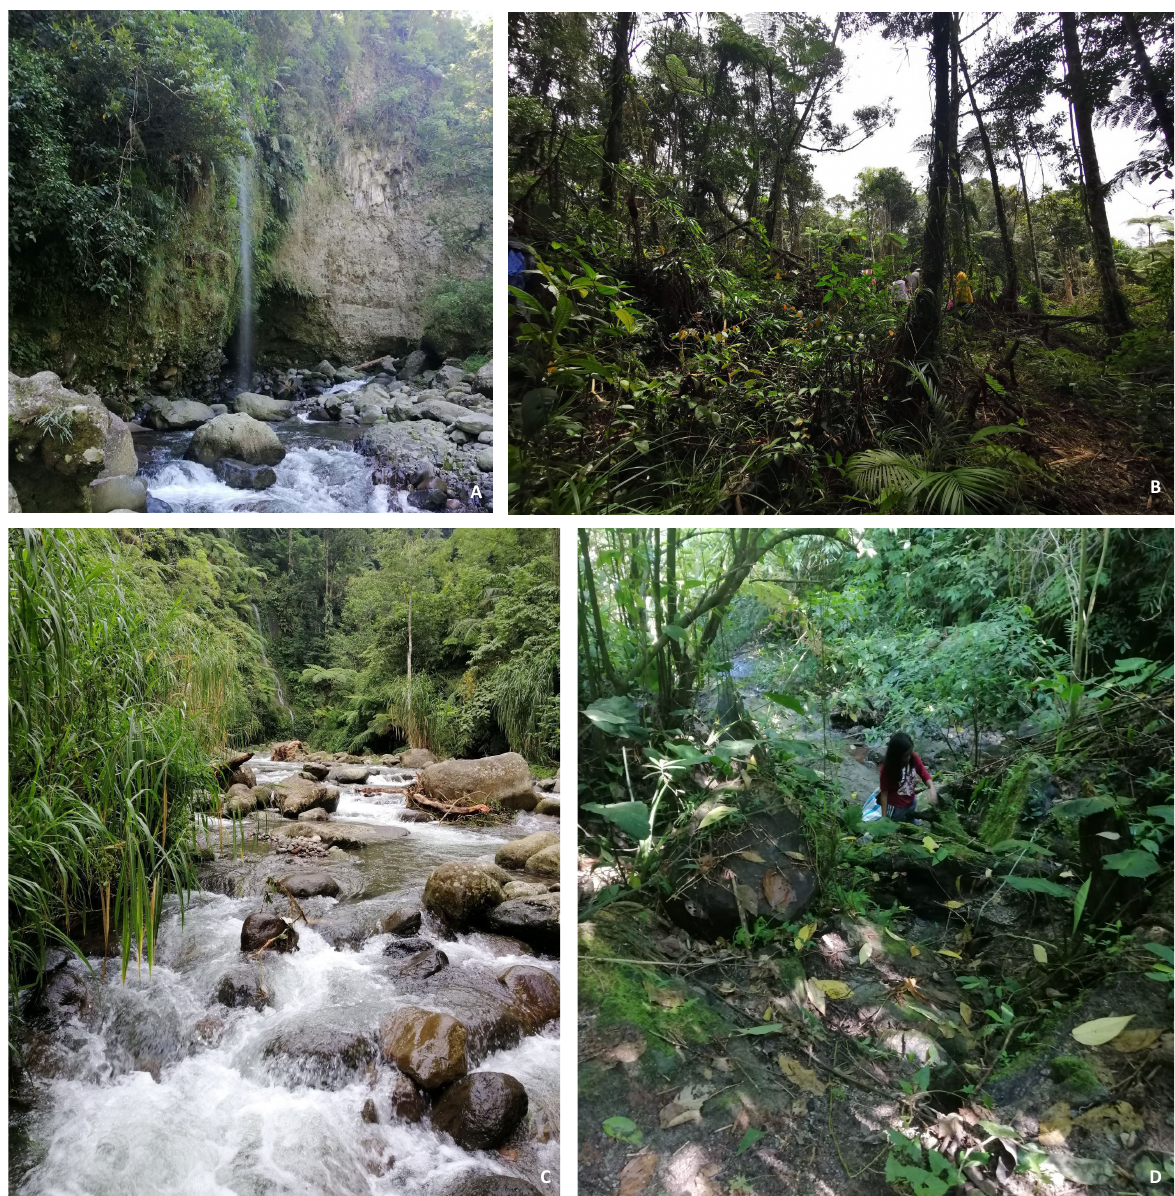
Image 3. Tiger beetle habitat in Mt. Hamiguitan and Marilog districts. A—Habitat of Thopeutica ( Thopeutica ) milinae (Wiesner, 1992) | B— Habitat of Tricondyla species | C—Habitat of Therates species | D—Habitat of Prothyma ( Symplecthyma ) heteromallicollis heteromallicollis (Horn, 1909). © M.N.D.